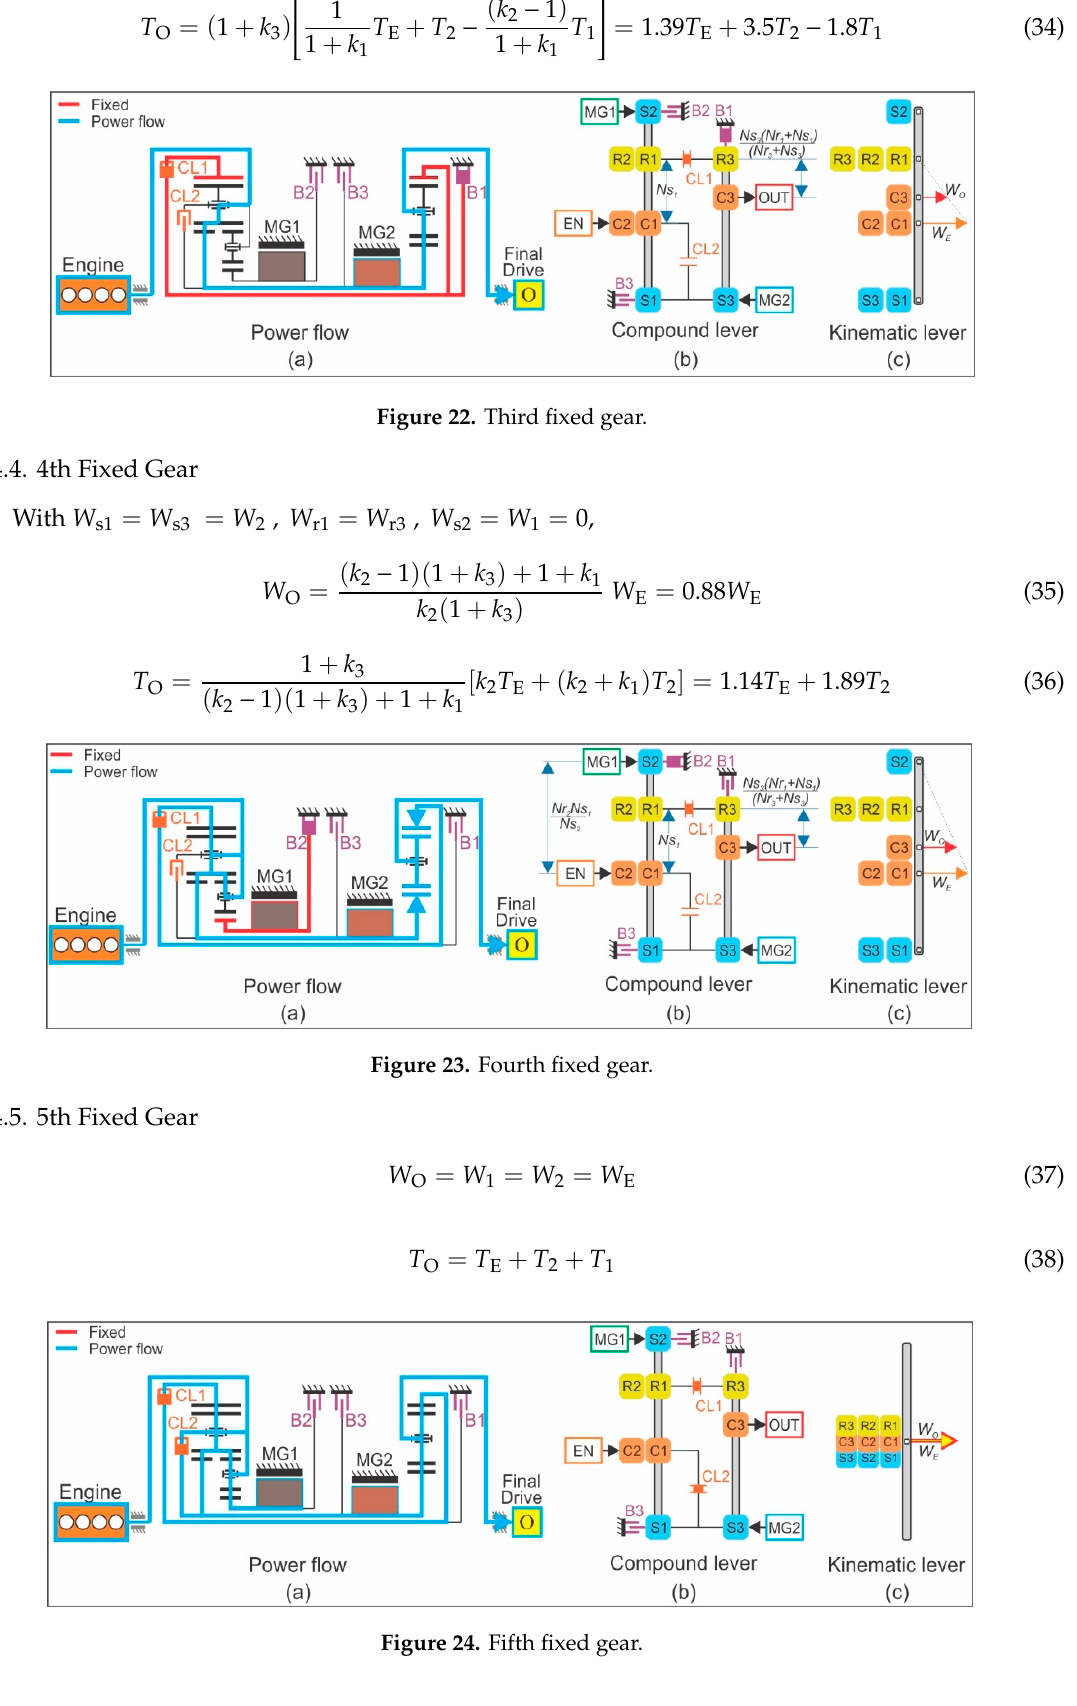
Figure 24. Fifth fixed gear.